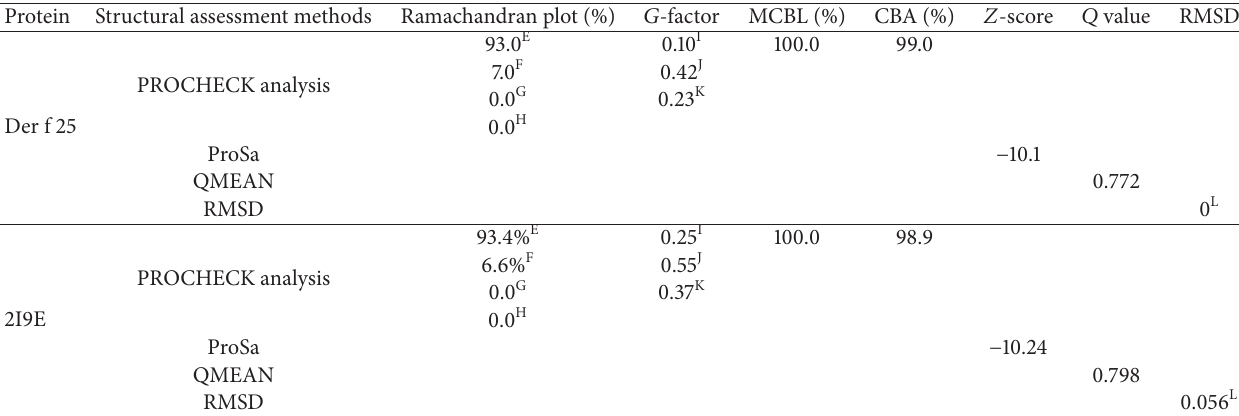
Table 1: Parameters used for proteins structural assessment. Protein Structural assessment methods